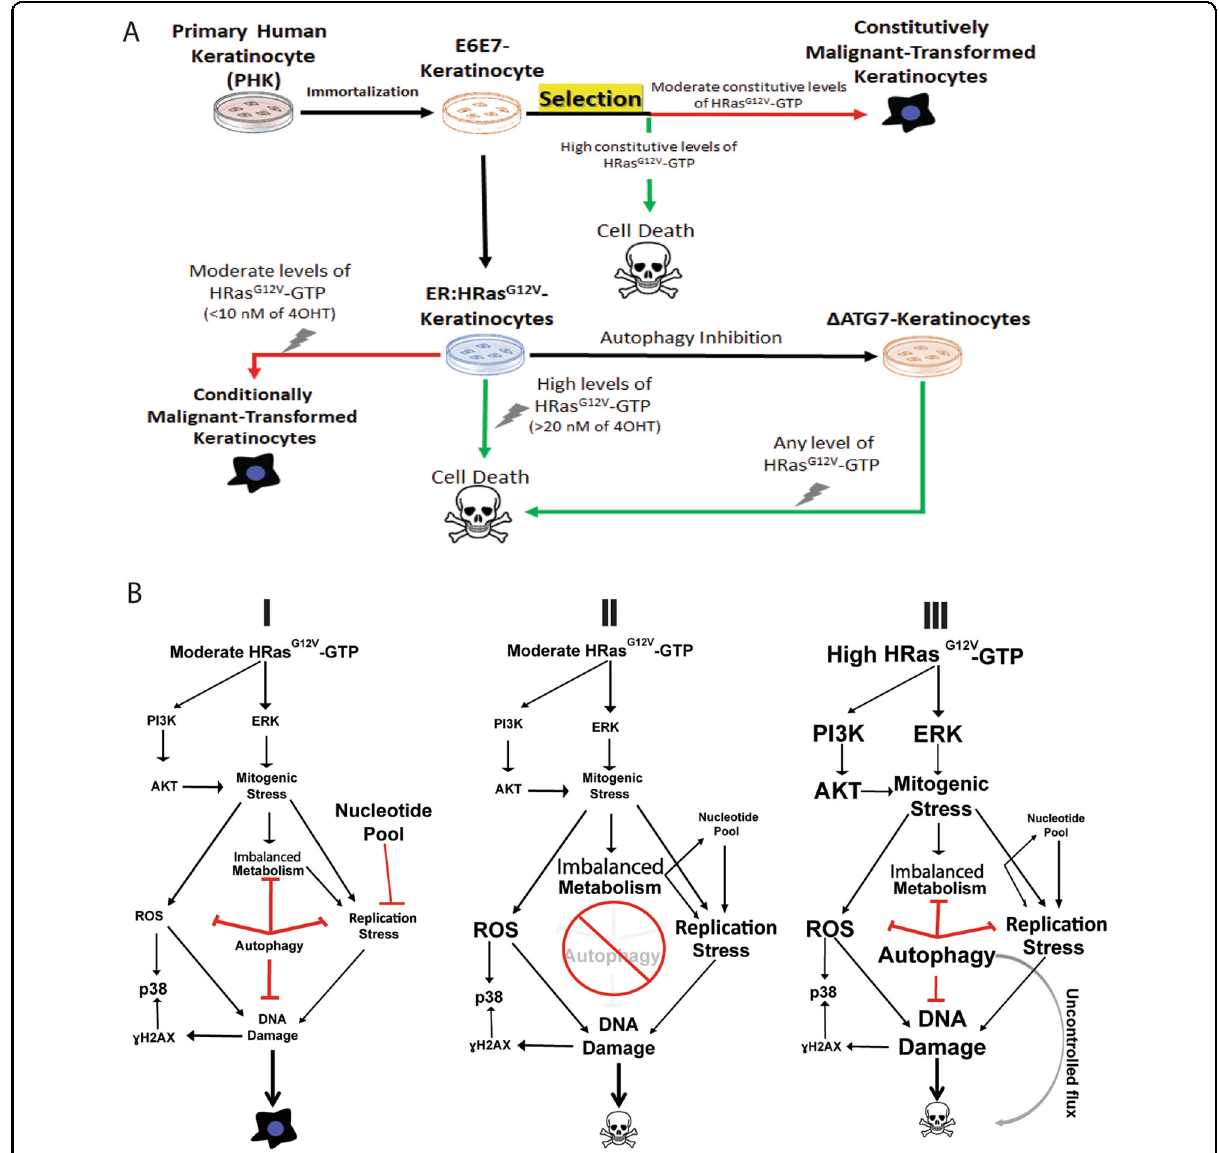
Fig. 8 HPV-primed keratinocytes require autophagy to counteract the oncogenic stress triggered by HRas G12V activity during the malignant transformation transition. A Step-by-step of the models generated and the role of HRas G12V activity in their fates. Note that the different levels of inducible ER:HRas G12V activity are mimicking the fates observed in the constitutive ones. In the constitutive model, we could observe only the product of a random selection of cells presenting low levels of HRas G12V activity. Nonetheless, using the inducible model, we were able to observe the phenomenon responsible for such selection. B Mechanistic model presenting the challenge that HPV-primed keratinocytes, in the transition to a malignant transformed phenotype, must bypass according to the intensity of oncogenic stress (ROS, imbalanced metabolism, replication stress, and DNA damage). The intensity of the oncogenic stress is determined by different levels of HRas G12V activity and it is counterbalanced by autophagic activity in a different fashion: (I) only a moderate level of HRas G12V activity is supported by immortalized E6E7 keratinocytes since the autophagy activity, also moderate, is capable of buffering the oncogenic stress generated. (II) However, without the recruitment of autophagy, any level of oncogenic stress is not tolerated, proving that autophagy is recruited primarily as a safeguard mechanism. (III) On the other hand, high levels of HRas G12V activity generate unbearable oncogenic stress followed by the activation of autophagy over the cell capacity of processing that becomes an additional source of stress leading to cell death. The different font sizes are expressing the levels of cell signaling/events